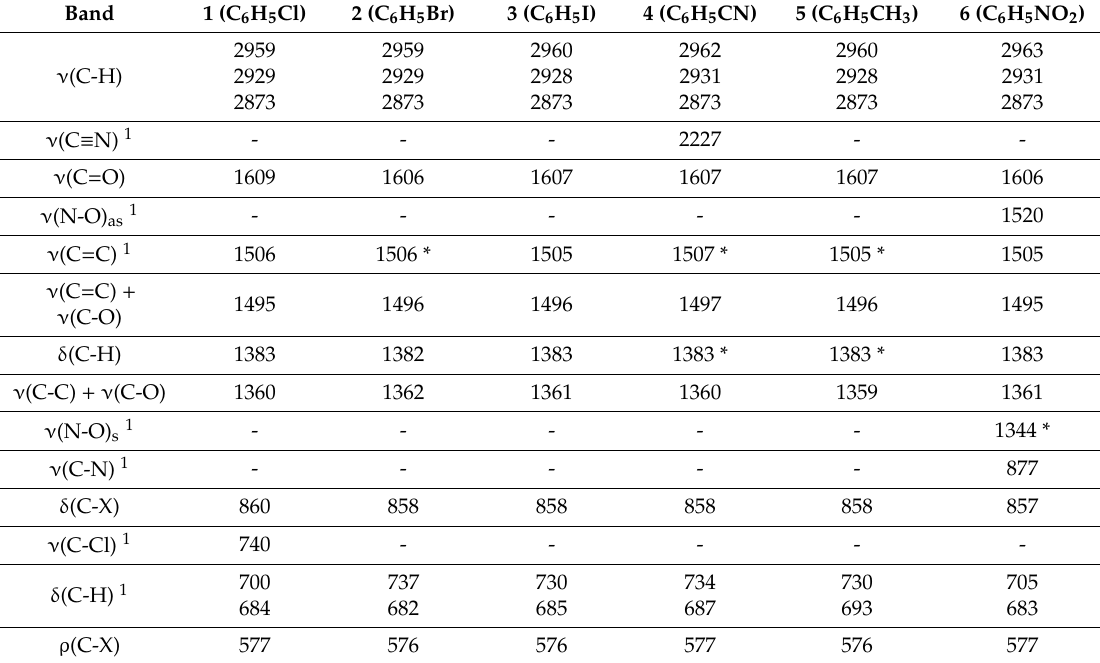
* shoulder; 1 Bands corresponding to the solvent molecules.